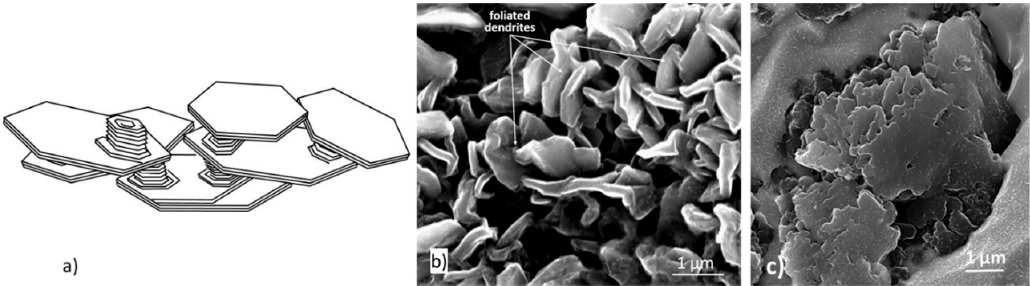
Figure 10. Foliated crystals growing as a dendrite: ( a ) Schematic representation, reproduced from [42] with permission from Springer; ( b ) foliated dendrites in a 0.18% Ti LG iron [30]; ( c ) foliated dendrites in chunky graphite, reproduced from [30] with permission from Elsevier.